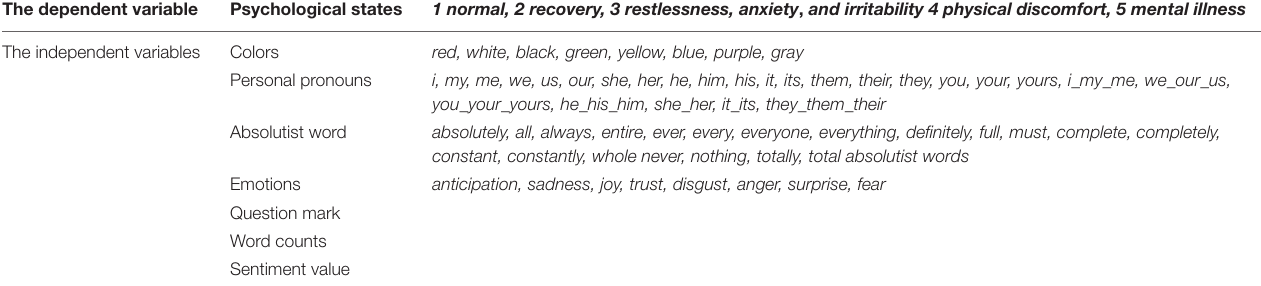
TABLE 1 | The classification of variables. The dependent